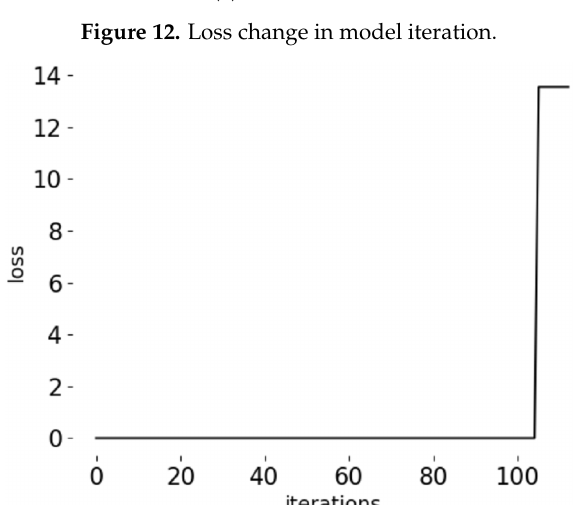
Figure 12. Loss change in model iteration.